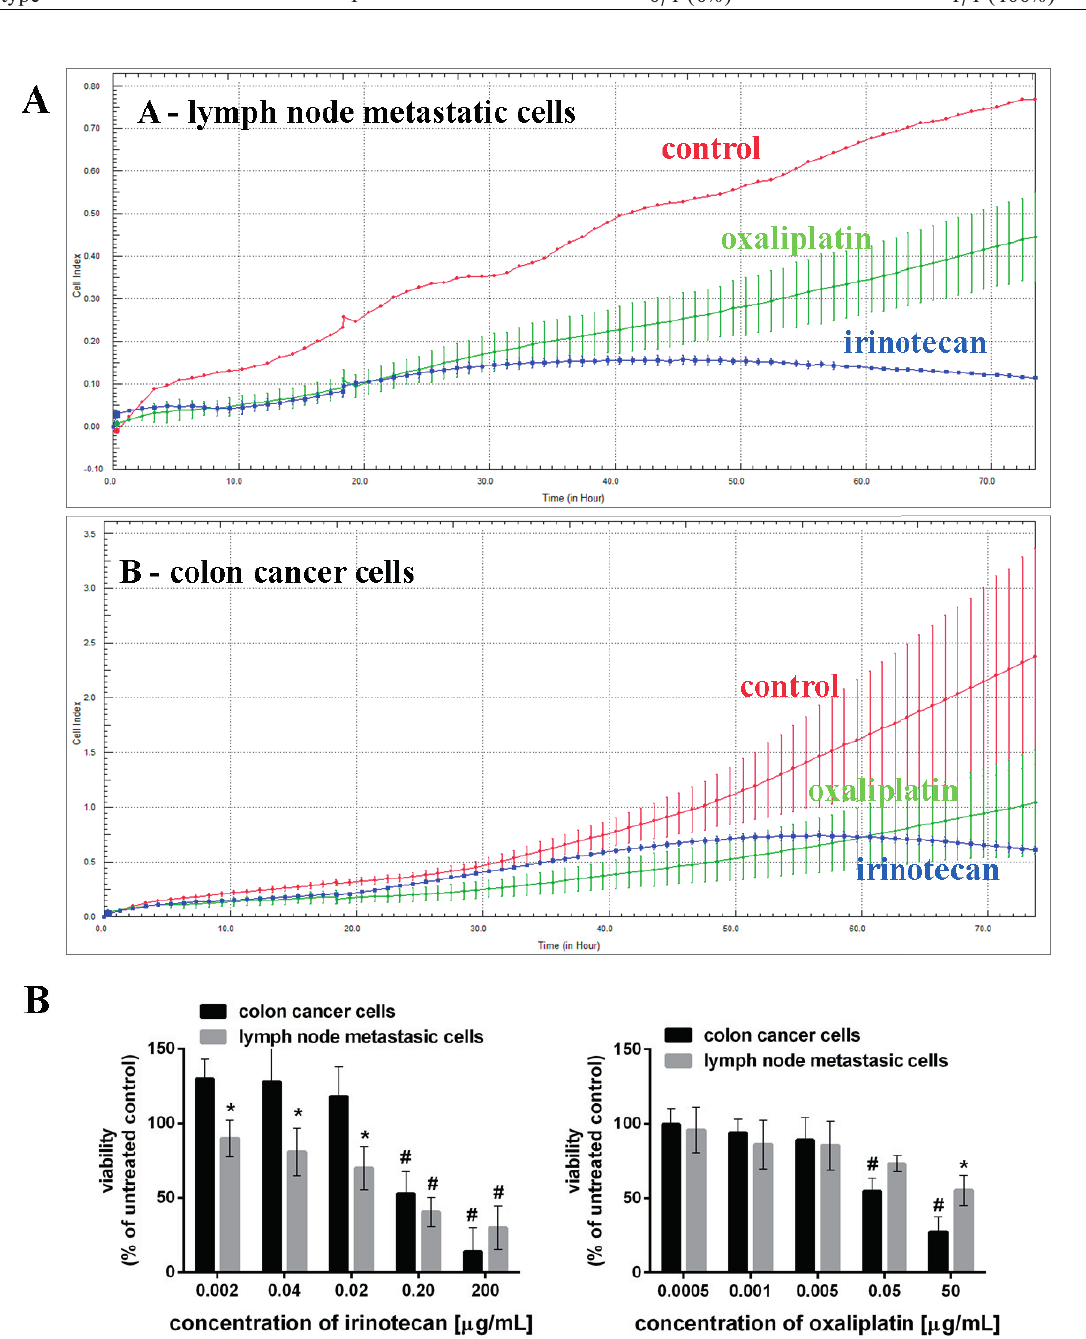
Fig. 4. Cell proliferation test of lymph node metastatic cells and colon cancer cells monitored by the X-CELLigence system (A). Cells were treated with irinotecan and oxaliplatin. Cell index values represent arbitrary units calculated from the relative changes in impedance. The viability (measured using the WST-1 test) (B) after 48h treatment of lymph node metastatic cells and colon cancer cells with irinotecan and oxaliplatin. Results were expressed as percentage of control (=100%). Data represent the mean ± SD from two independent experiments. * P <0.05 primary colon cancer cells versus respective lymph node metastatic cells; # P <0.05 treated cells versus untreated